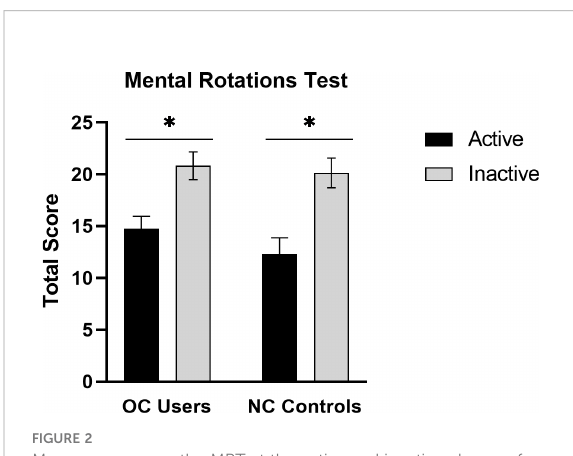
FIGURE 2 Mean accuracy on the MRT at the active and inactive phases of the menstrual cycle in oral contraceptive users (OC users, n = 61) and naturally-cycling controls (NC controls, n = 44). A robust phase-of-cycle effect was found in both groups. Among OC users, mental rotation performance was superior during the inactive